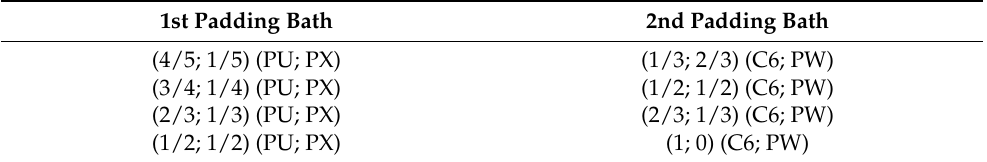
Table 5. Different combinations